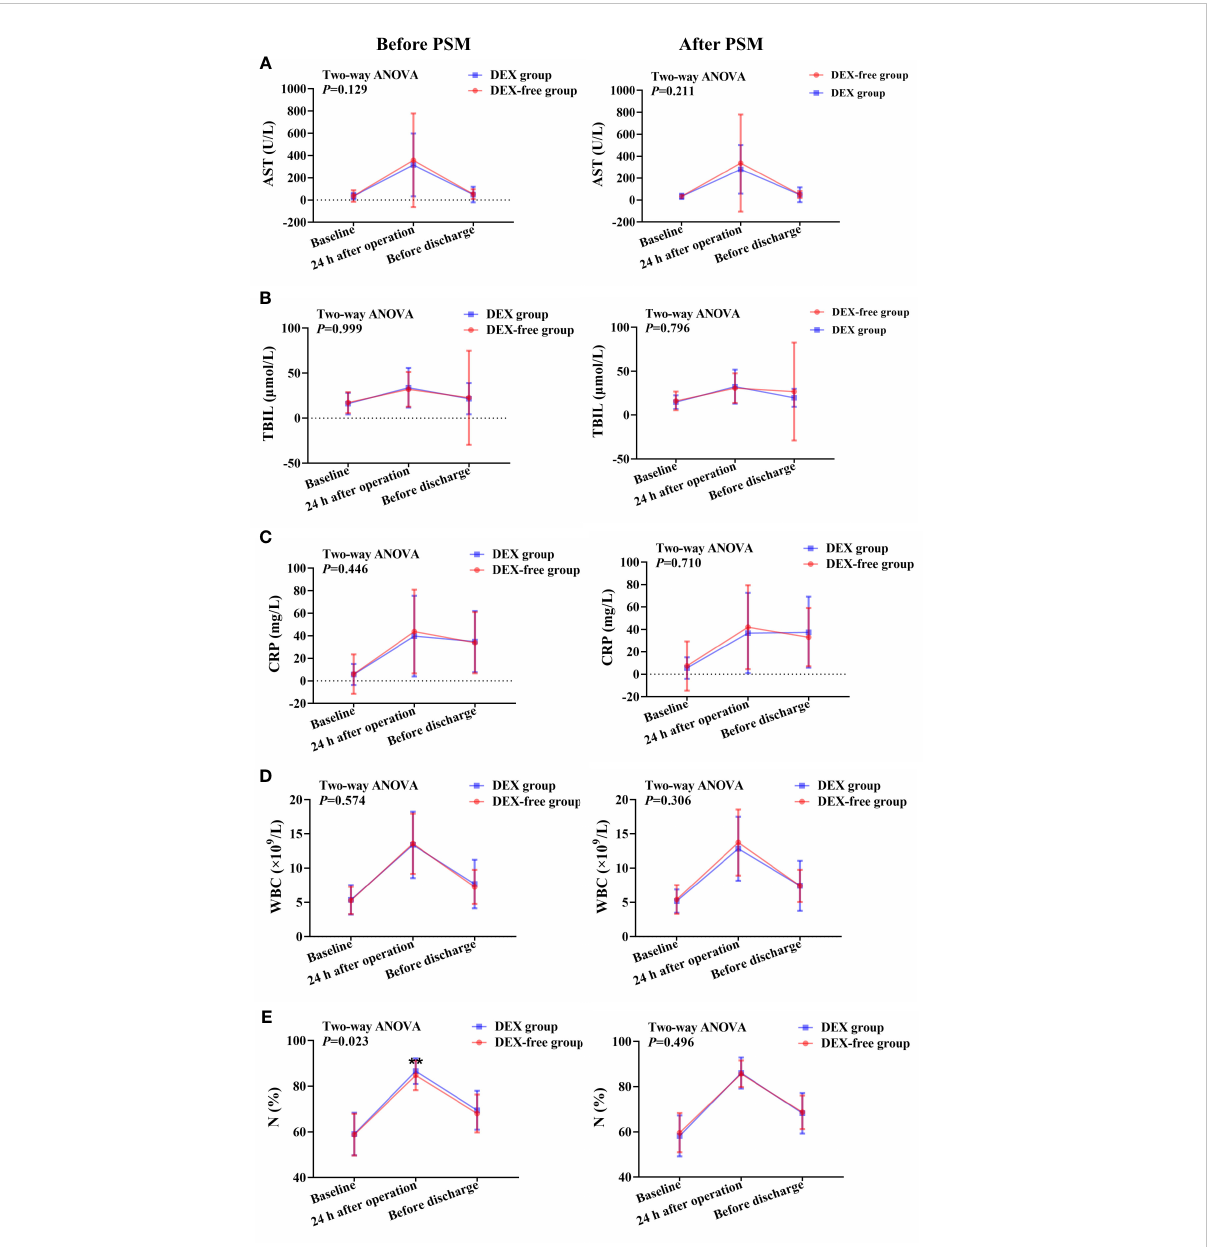
FIGURE 3 Expression levels of biomarkers of liver function and in fl ammation at various time points in patients undergoing hepatectomy before and after PSM. (A) , serum AST levels; (B) , serum TBIL levels; (C) , serum CRP levels; (D) , peripheral WBC count; (E) , percentage of neutrophils (N%) in peripheral blood. Data were expressed as mean ± standard deviation. **, P <